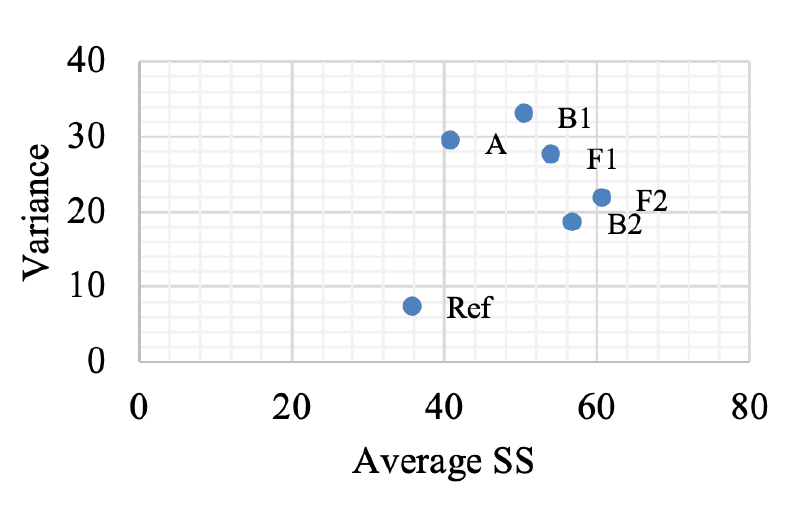
Figure 5. Scatter plot of Average SS vs